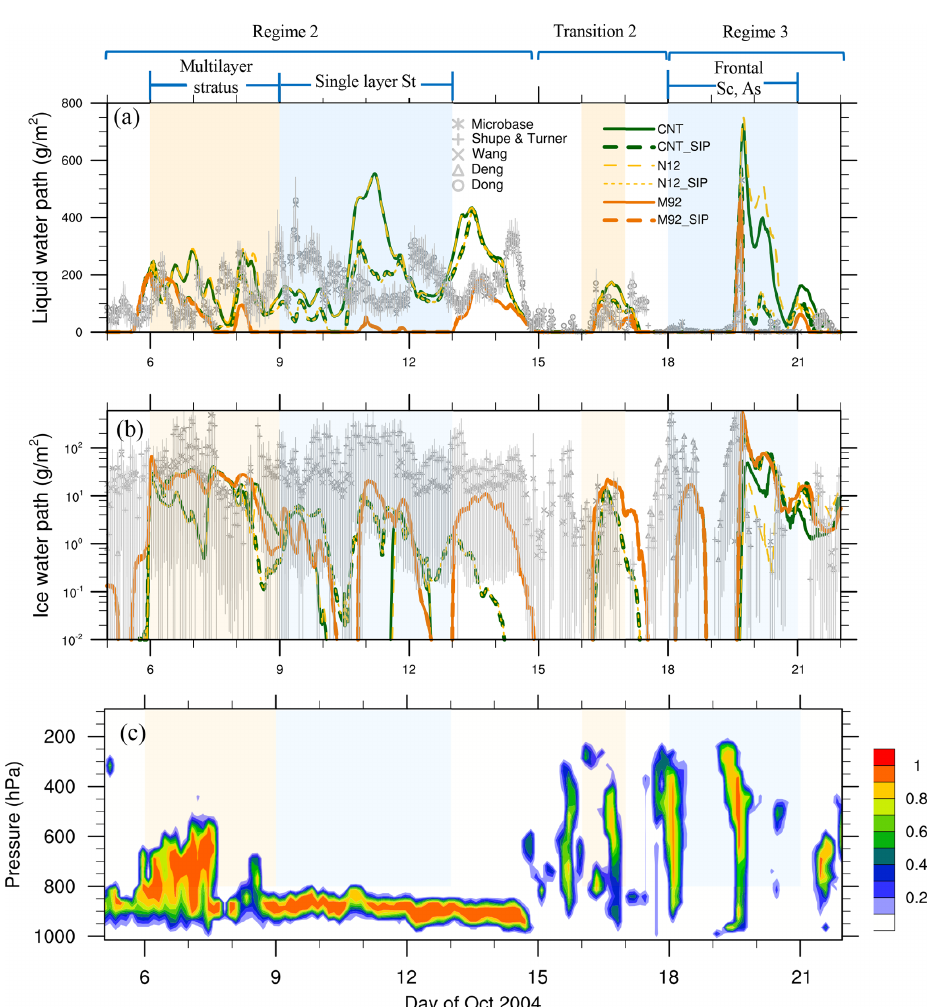
Figure 1. Temporal evolution of (a) LWP and (b) IWP from remote sensing retrievals (symbols) and CNT, CNT_SIP, N12, N12_SIP, M92, and M92_SIP experiments (lines); (c) vertical distribution of observed cloud fraction. The light orange shadings show the multilayer stratus and transition periods; light blue shadings show the single-layer stratus and frontal clouds periods. Vertical gray lines represent the standard deviations of retrieval data. Note that N12 (N12_SIP) coincides with CNT (CNT_SIP) during the single-layer stratus cloud